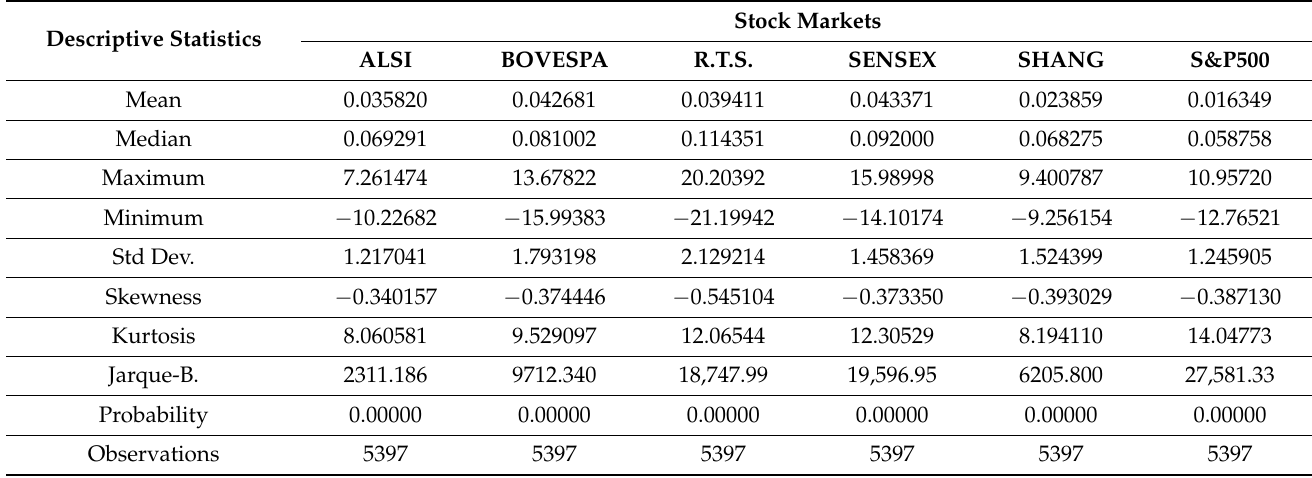
Table 1. Descriptive statistics of the stock market returns of the BRICS and the US.